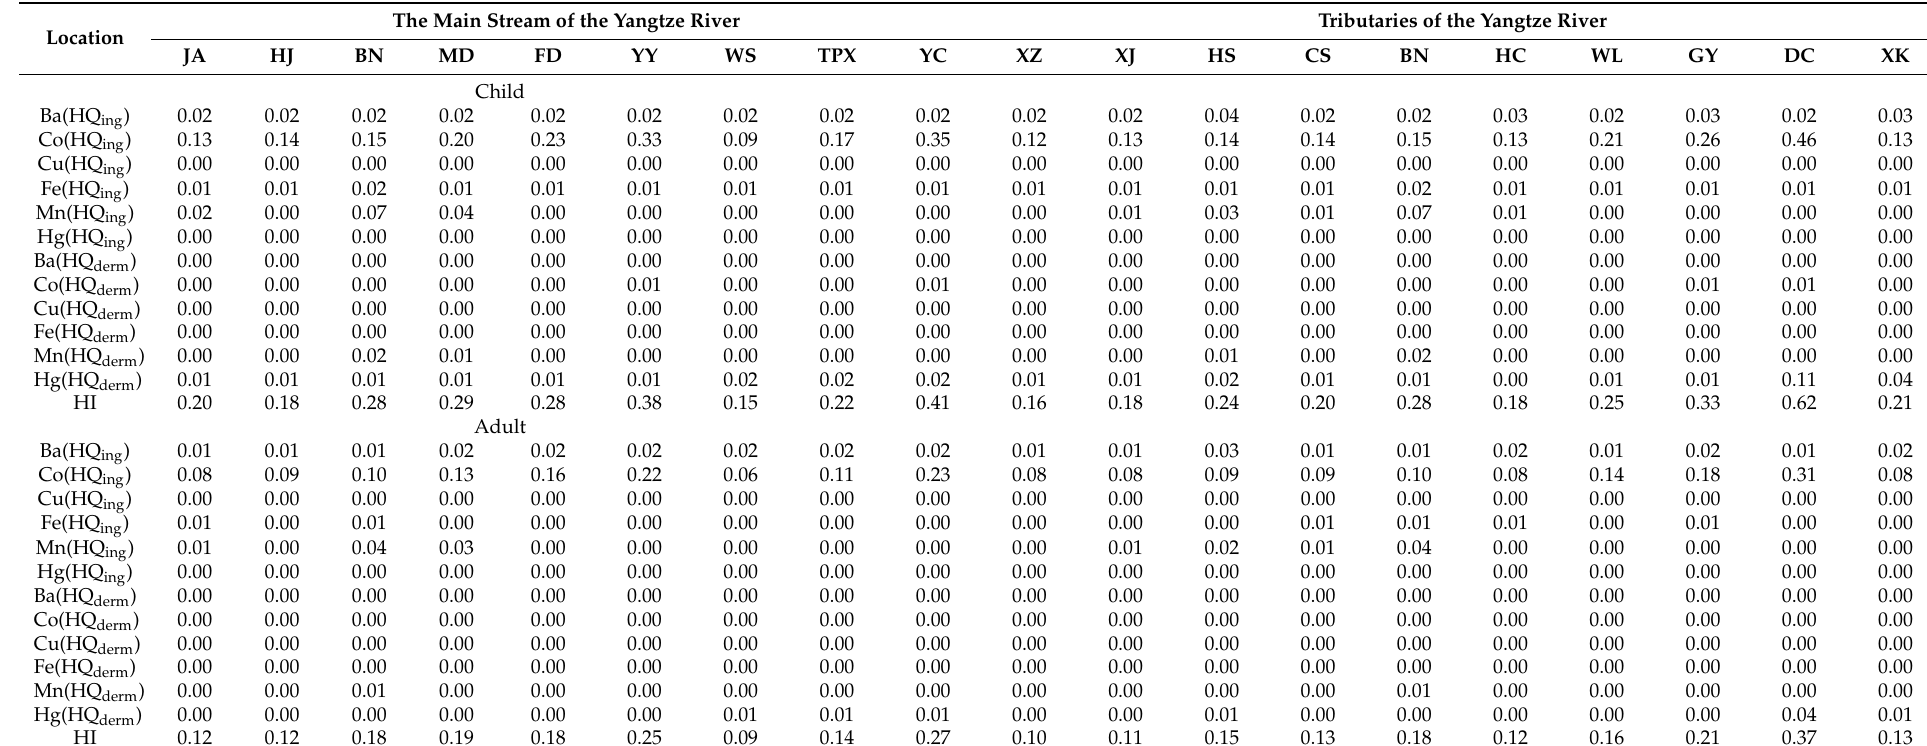
Table 6. Hazard quotient (HQ) and hazard index (HI) of each investigated element in the water